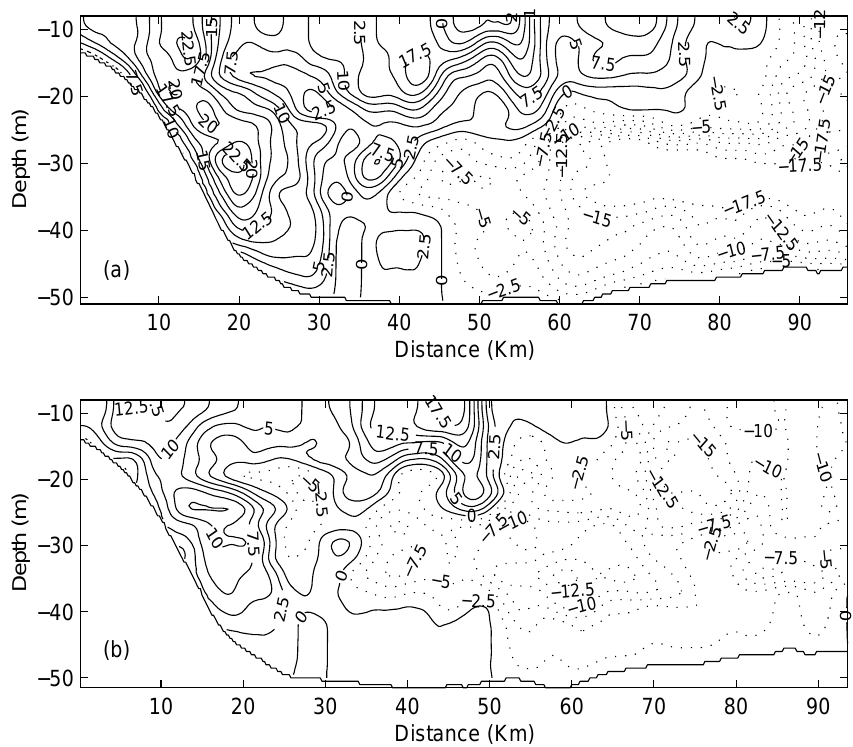
Fig. 13. Residual currents at transect B on 22 September (a) and on 23 September (b) . The component of the current perpendicular to the section is depicted. Positive values mean southward flow. No data are available in the layer from the surface to the 9m depth.